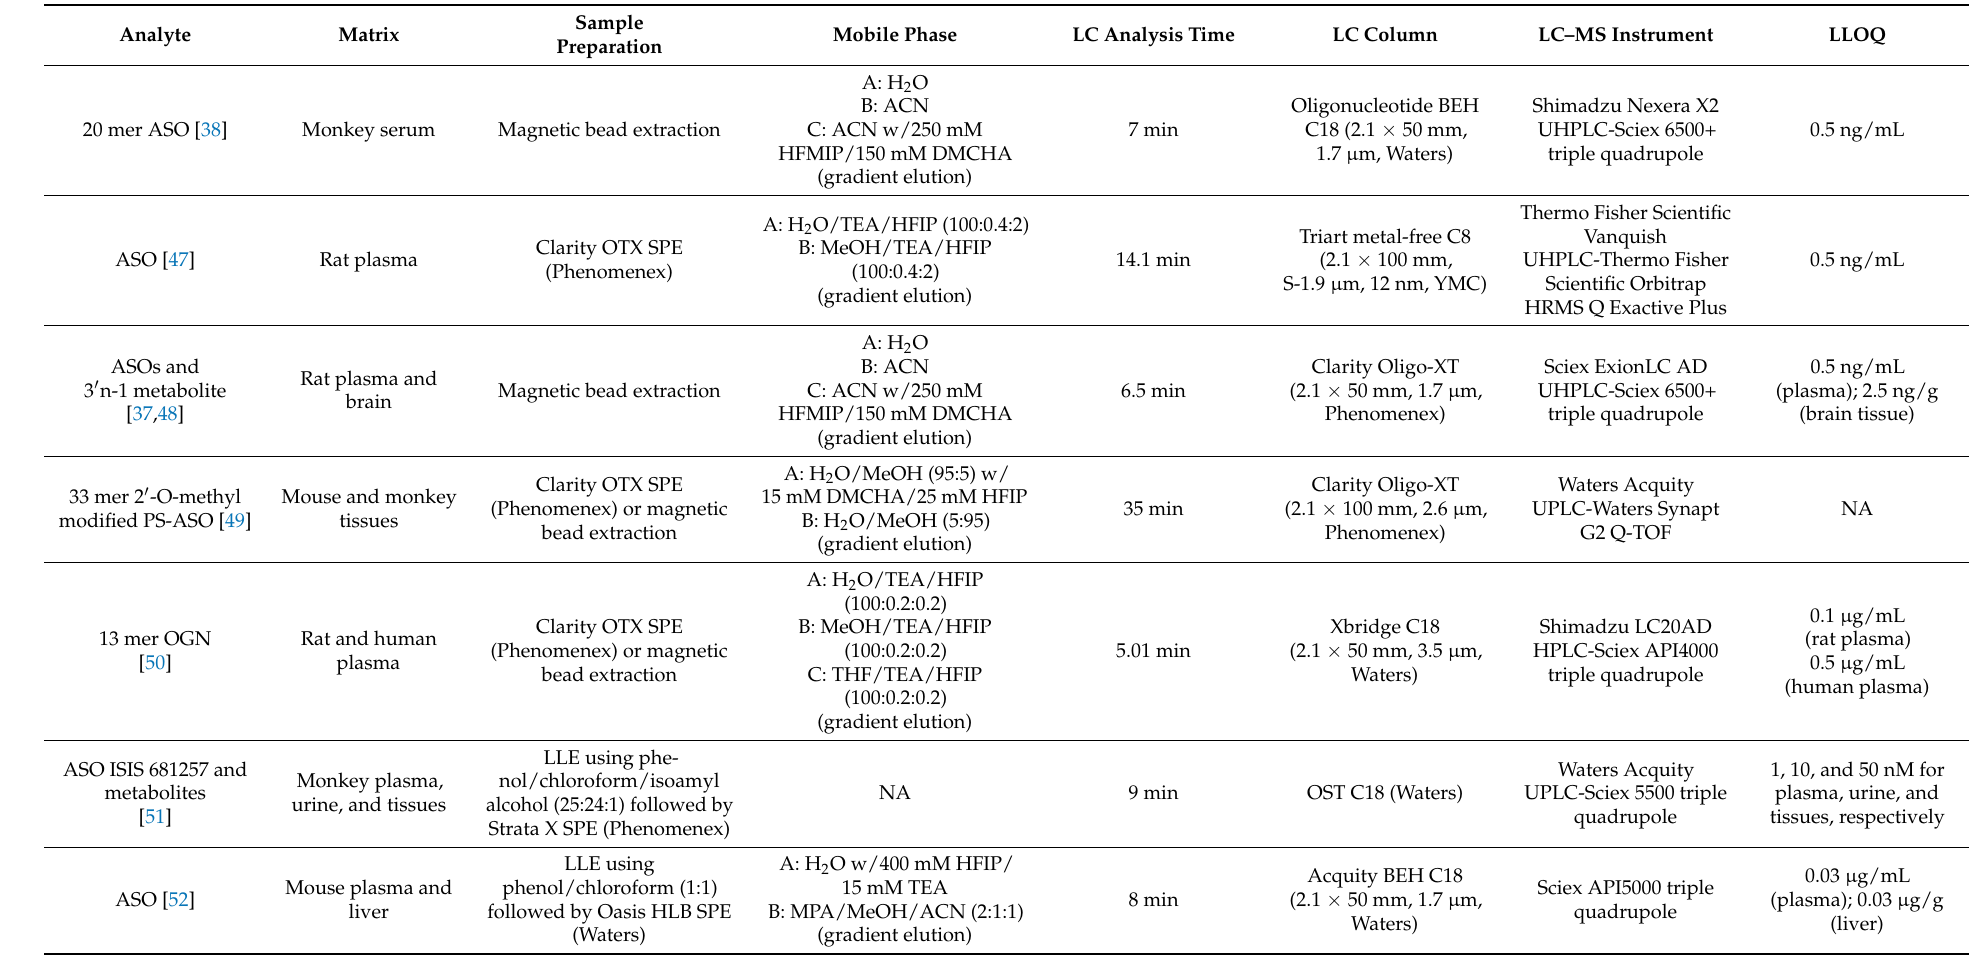
Table 3. Bioanalysis methods for therapeutic oligonucleotides published during 2012–2022 (until August